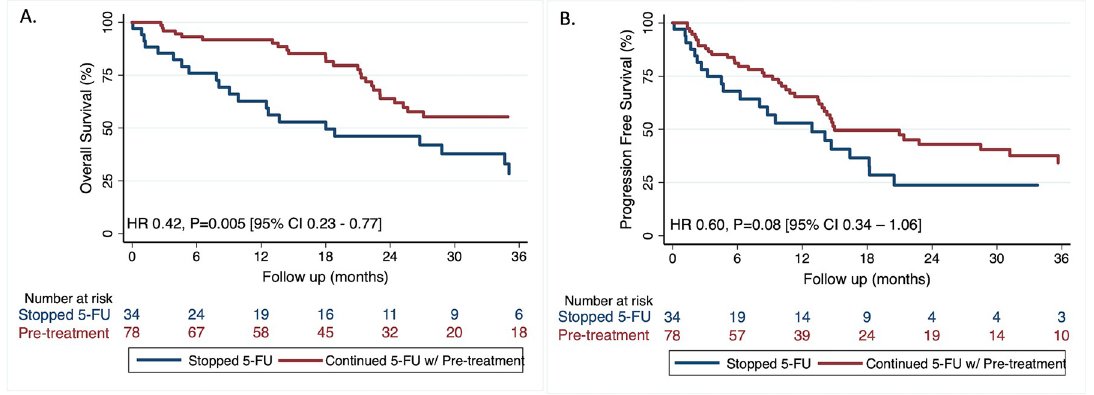
Fig 3. Kaplan-Meier curves for overall survival and progression free survival for 5-FU associated coronary vasospasm patients. Comparison of (A) overall survival and (B) progression free survival in patients who developed 5-FU associated coronary vasospasm